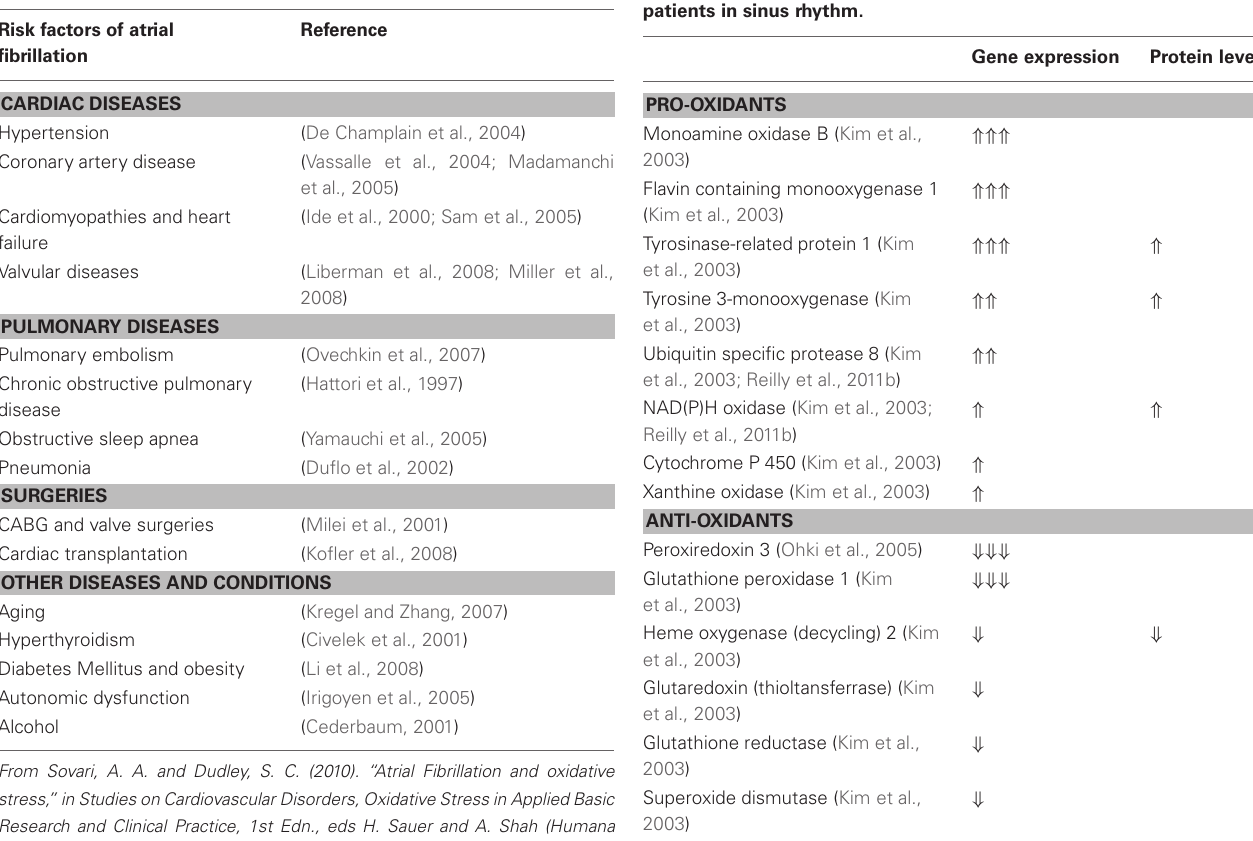
Table 4 | Main clinical risk factors of atrial fibrillation and their association with oxidative stress.